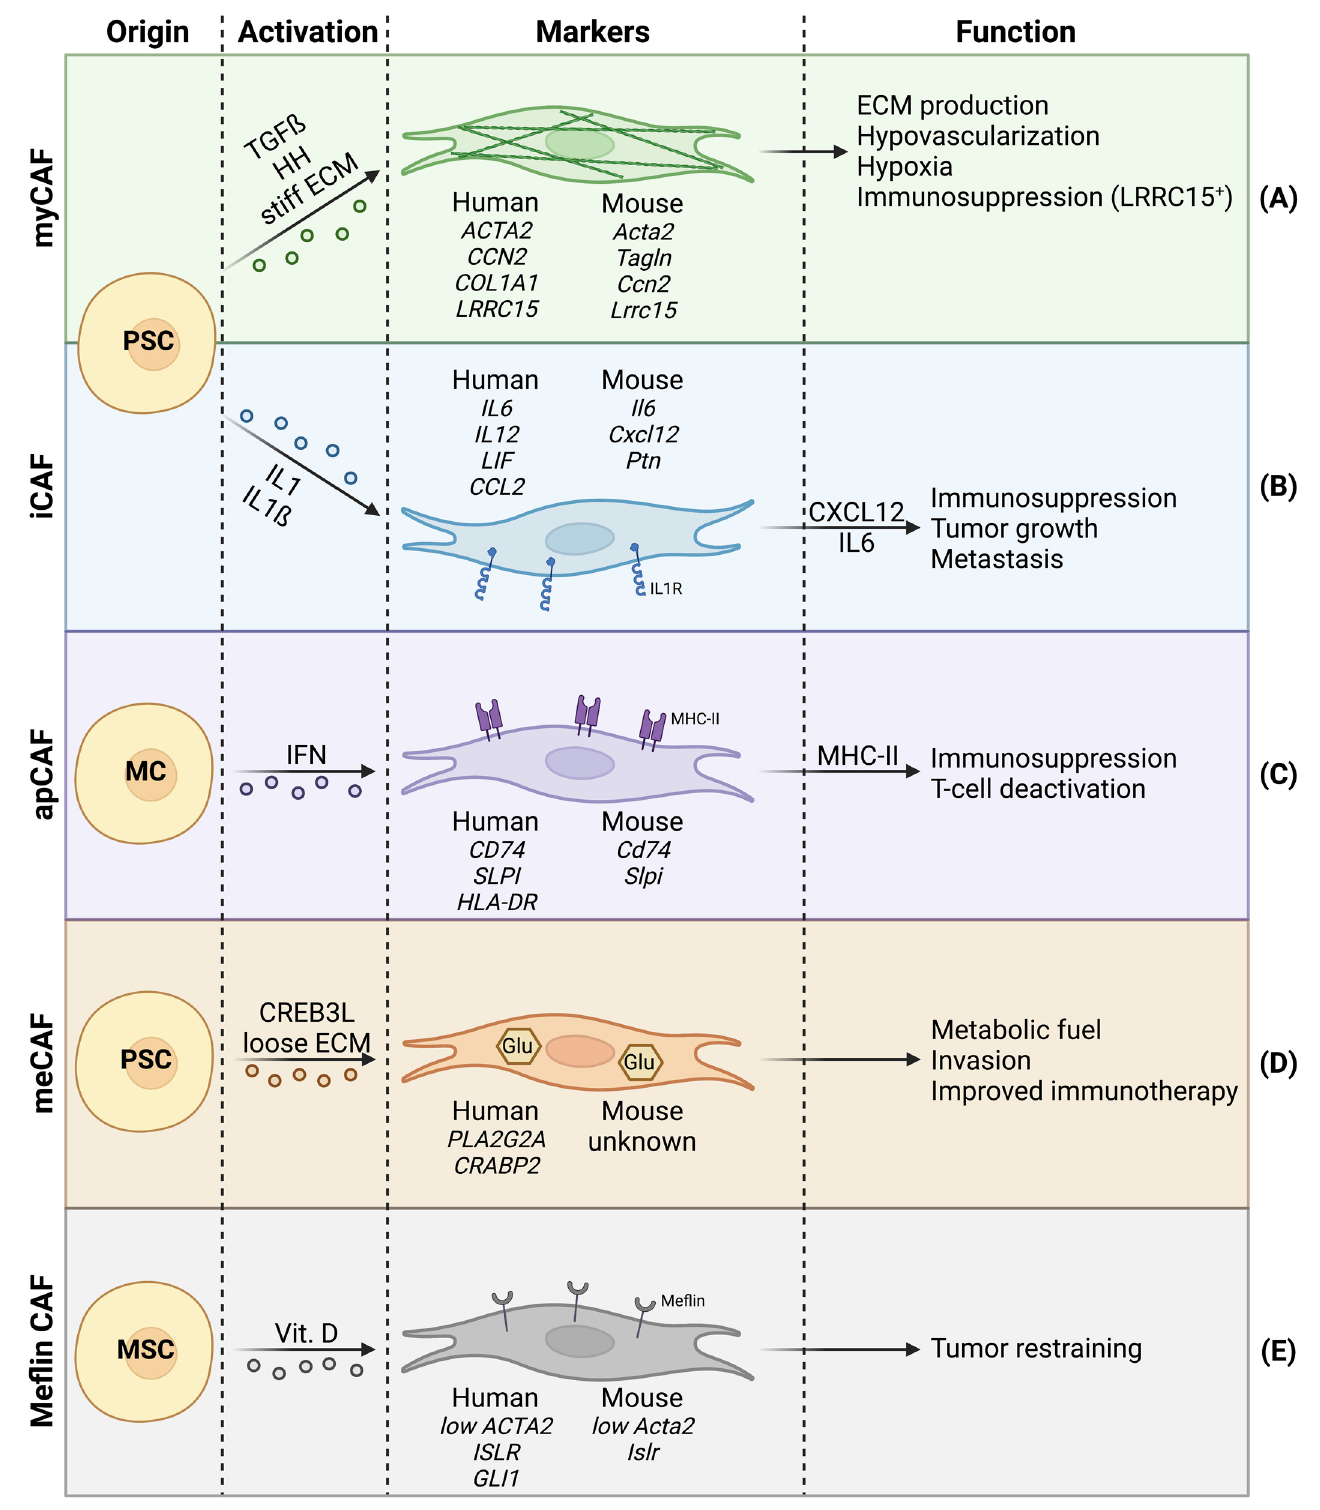
Figure 1. Cancer-associated fibroblast (CAF) heterogeneity in PDAC, with focus on cell of origin, activator signals, species-dependent markers, and functions. ( A ) Myofibroblastic CAFs with high alpha-SMA expression. ( B ) Inflammatory CAFs showing abundant IL1 receptors. ( C ) Antigen- presenting CAFs that express MHC-II. ( D ) Metabolic CAFs bearing increased glycolysis. ( E ) Meflin + CAFs with tumor-restraining properties.